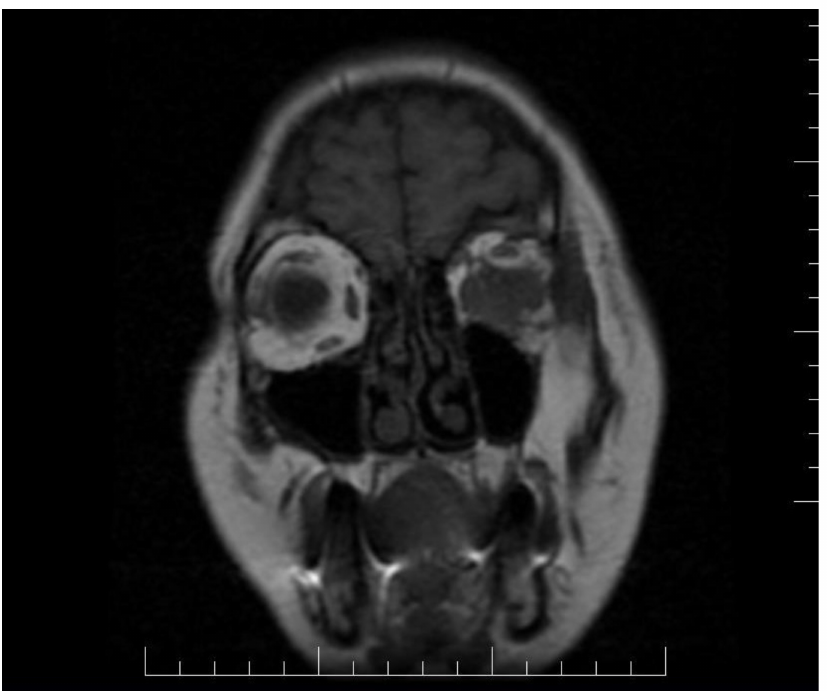
Figure 2. Brain MRI exhibiting a left retroocular intraorbital tumor, which infiltrated the ocular muscles in three out of quarter